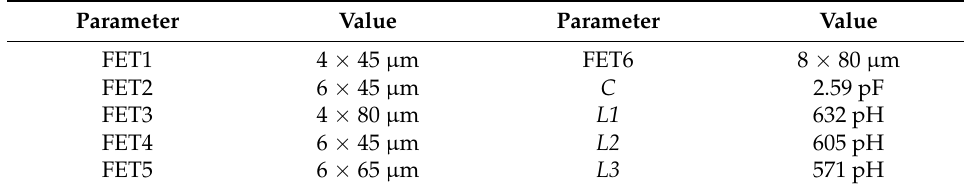
Figure 2. The structure of the absorptive single pole single throw (SPST) switch. Table 1. The parameters of SPST switch design.